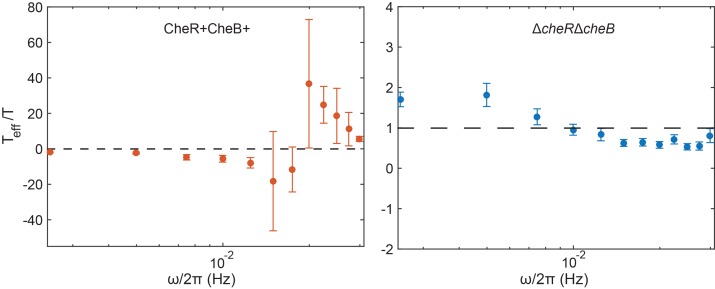
Calculated effective temperatures.Plots show the inverse of the quantities plotted in insets of Figure 4B,C, for ΔcheRΔcheB and for CheR+ CheB+ cells respectively. Dashed lines represent Teff=0 (CheR+ CheB+) and Teff=T (ΔcheRΔcheB). Error bars and statistics are as in the main figure.